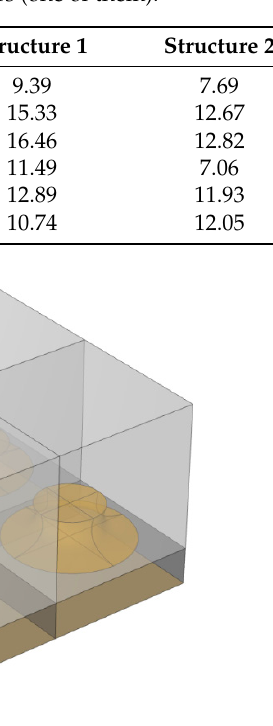
Figure 14. Optimized structure (one of them). Table 5. Optimized parameters (one of them).